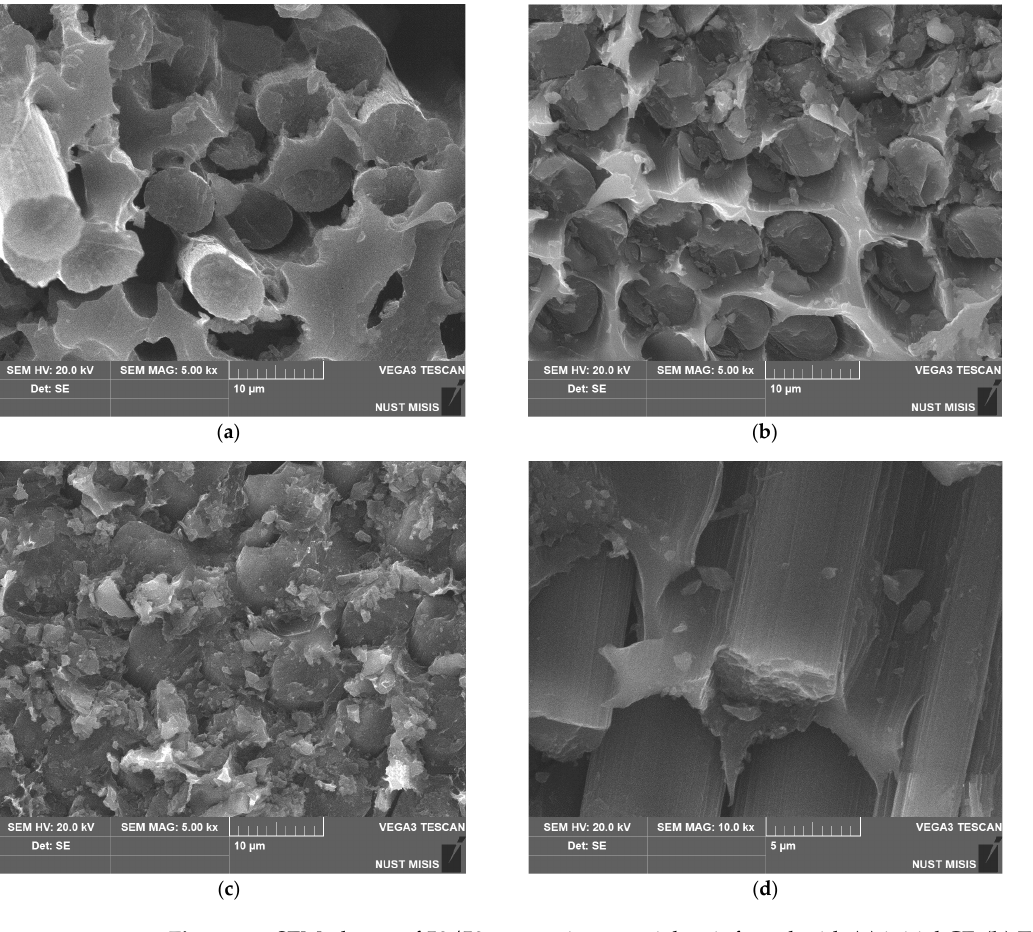
Figure 11. HDT curves of composites reinforced with ( a ) initial CF and ( b ) CF after surface modification (fiber content of 50 wt. %).